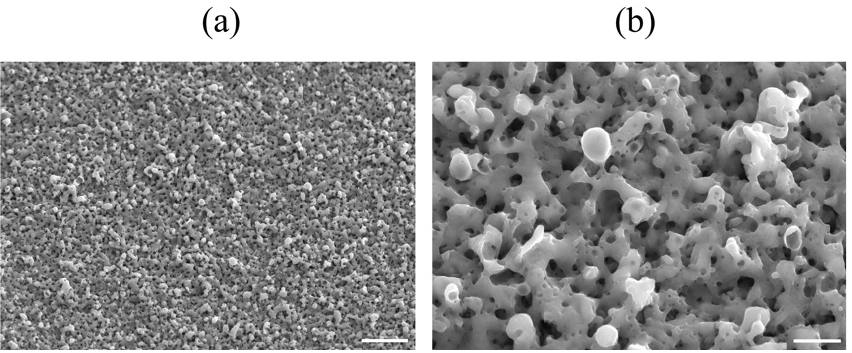
Figure 8. SEM images of the anodic oxides prepared in 1 M sulfuric acid electrolyte on TiNbSn alloy . Representative SEM images of the anodic oxides prepared in 1 M sulfuric acid electrolyte on TiNbSn alloy. ( a ) Low magnification: scale bar indicates 10.0 µ m, ( b ) high magnification: scale bar indicates 2.0 µ m. SEM: Scanning electron microscopy.